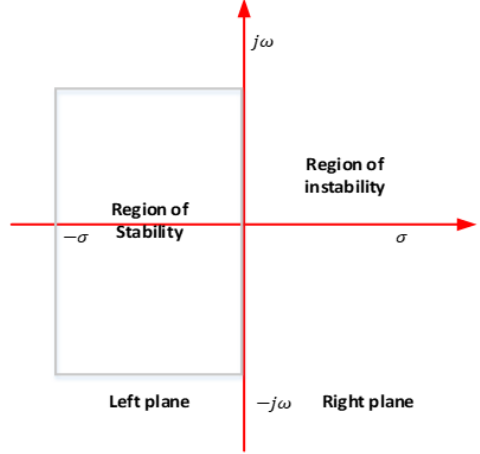
Figure 22. Stability criteria for eigenvalues are represented in the s-plane [102]. If all the eigenvalues are on the left side of the s-plane, then the system is deemed stable. In contrast, if there is any eigenvalue on the right side of the s-plane, then the system is not stable. Shifting the eigenvalues to the left side of the s-plane is the major function of optimization algorithms in the design of damping